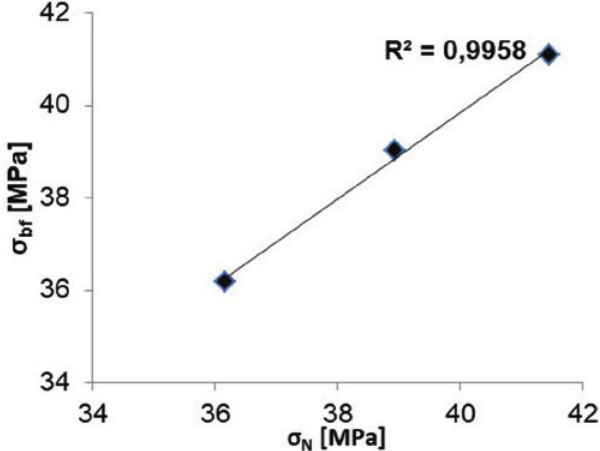
Figura 16 Valores das tensões nominais máximas obtidas dos resultados experimentais ( σ à flexão máximas calculadas ( σ flexão de elementos de concreto armado reforçados com fibras.